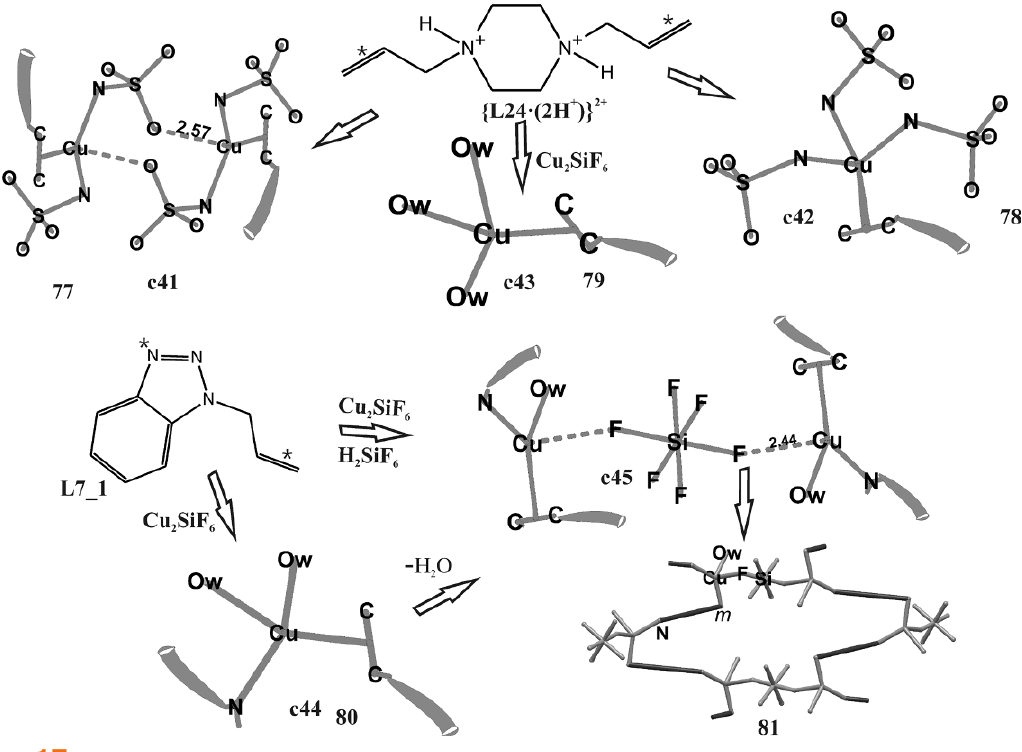
Figure 17. Structural genesis of C41-C45 fragments in 77-81 compounds.